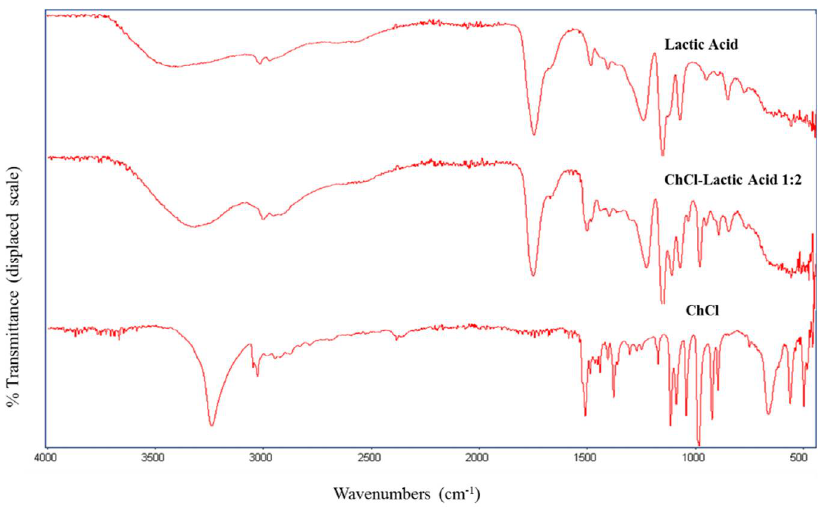
Figure 2. FTIR spectra of lactic acid, ChCl–lactic acid molar ratio 1:2, and ChCl.